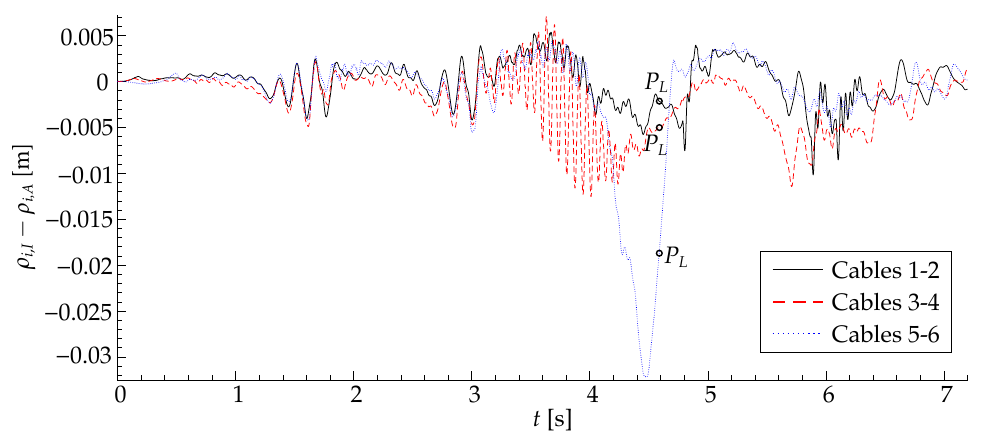
Figure 16. Cable length errors between the ideal cable lengths ρ i , I and the actual ones ρ i , A during a launch along the trajectory in Figure 6. The launch occurs at P L